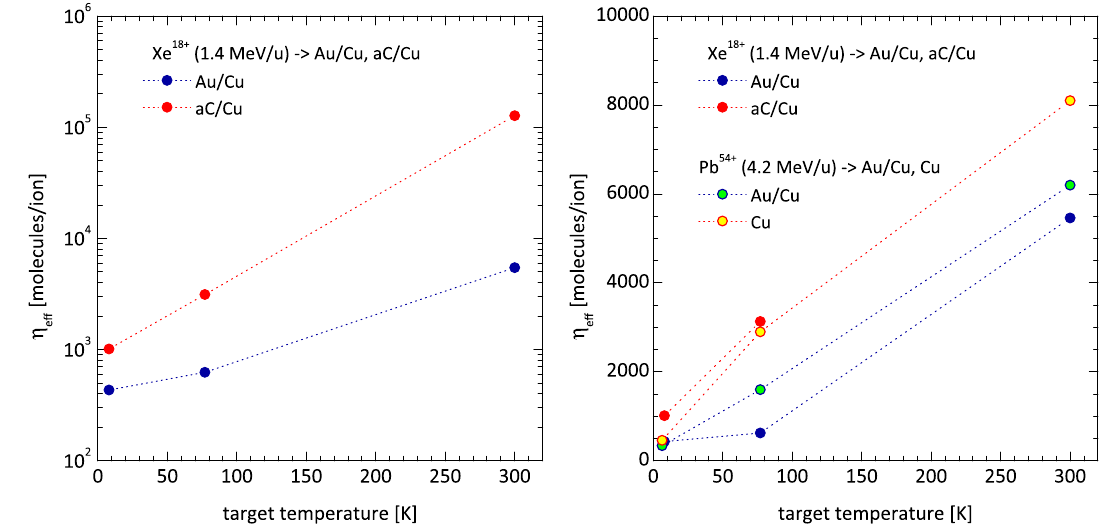
FIG. 8. Left: temperature dependence of the heavy-ion-induced desorption yield of gold-coated and amorphous-carbon-coated copper surfaces bombarded under (cid:2) ¼ 0 (cid:2) with 1 : 4 MeV = u Xe 18 þ ions. Right: comparison of LINAC 3 desorption data obtained for 4 : 2 MeV = u Pb 54 þ ions bombarding bare and gold-coated copper targets under (cid:2) ¼ 0 (cid:2)